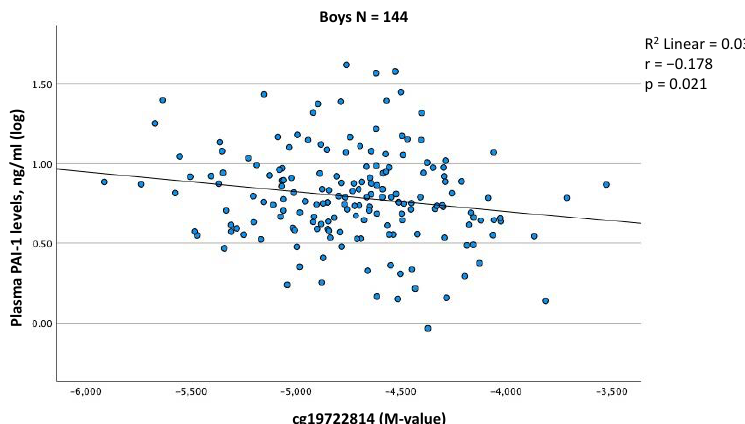
Figure 2. A significant association between blood cell DNAm levels at the SERPINE1 gene locus (cg19722814) and plasma PAI-1 levels at 5 years of age, in boys. Partial Pearson’s correlation, adjusted for age, batch effect, cell-type heterogeneity, and BMI, was considered statistically significant at p < 0.05.